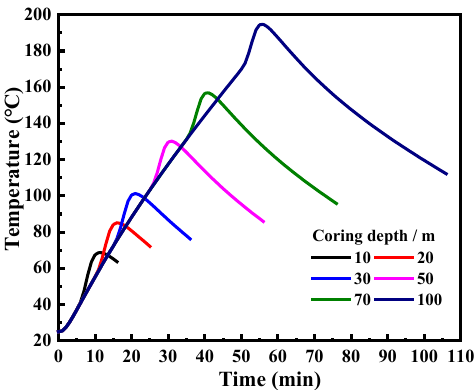
Figure 14. Temperature variation law of measuring point on the core tube wall at different core depths in JLS.